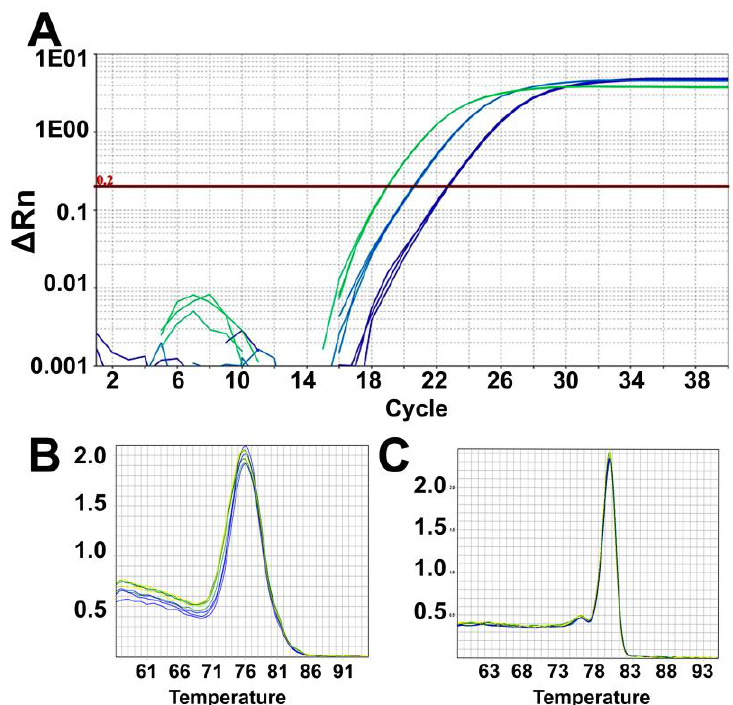
Figure 3. Expected PCR results. A representative amplification plot for three DNA concentrations performed in triplicates (100 ng/μL, green curves; 25 ng/μL, cyan curves and 6.25 ng/μL, blue curves). All replicates have almost identical cycle threshold value, and for each four-fold dilution, the cycle threshold values increase by two cycles. Representative images of the melt curve for telomere PCR products (B) and human β-globin PCR products (C).